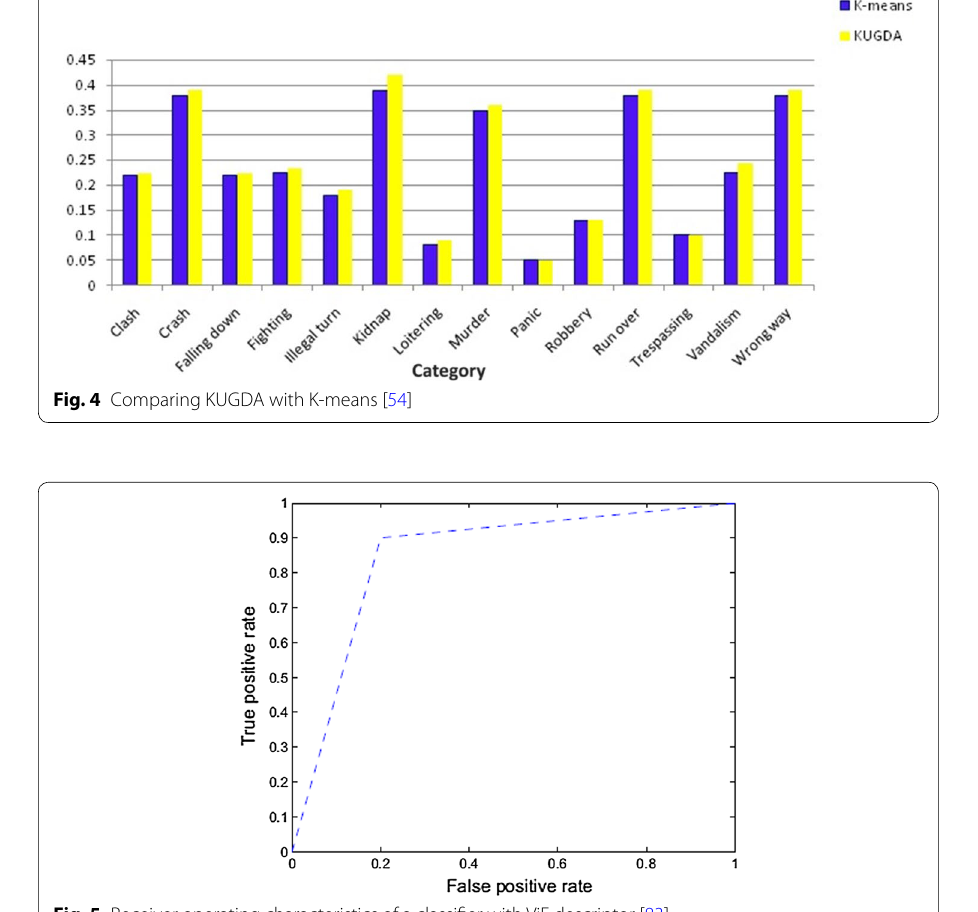
Fig. 5 Receiver operating characteristics of a classifier with ViF descriptor [83]